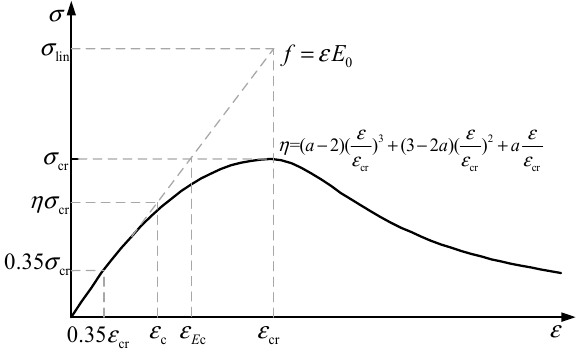
Figure 5. Stress–strain curve of concrete.